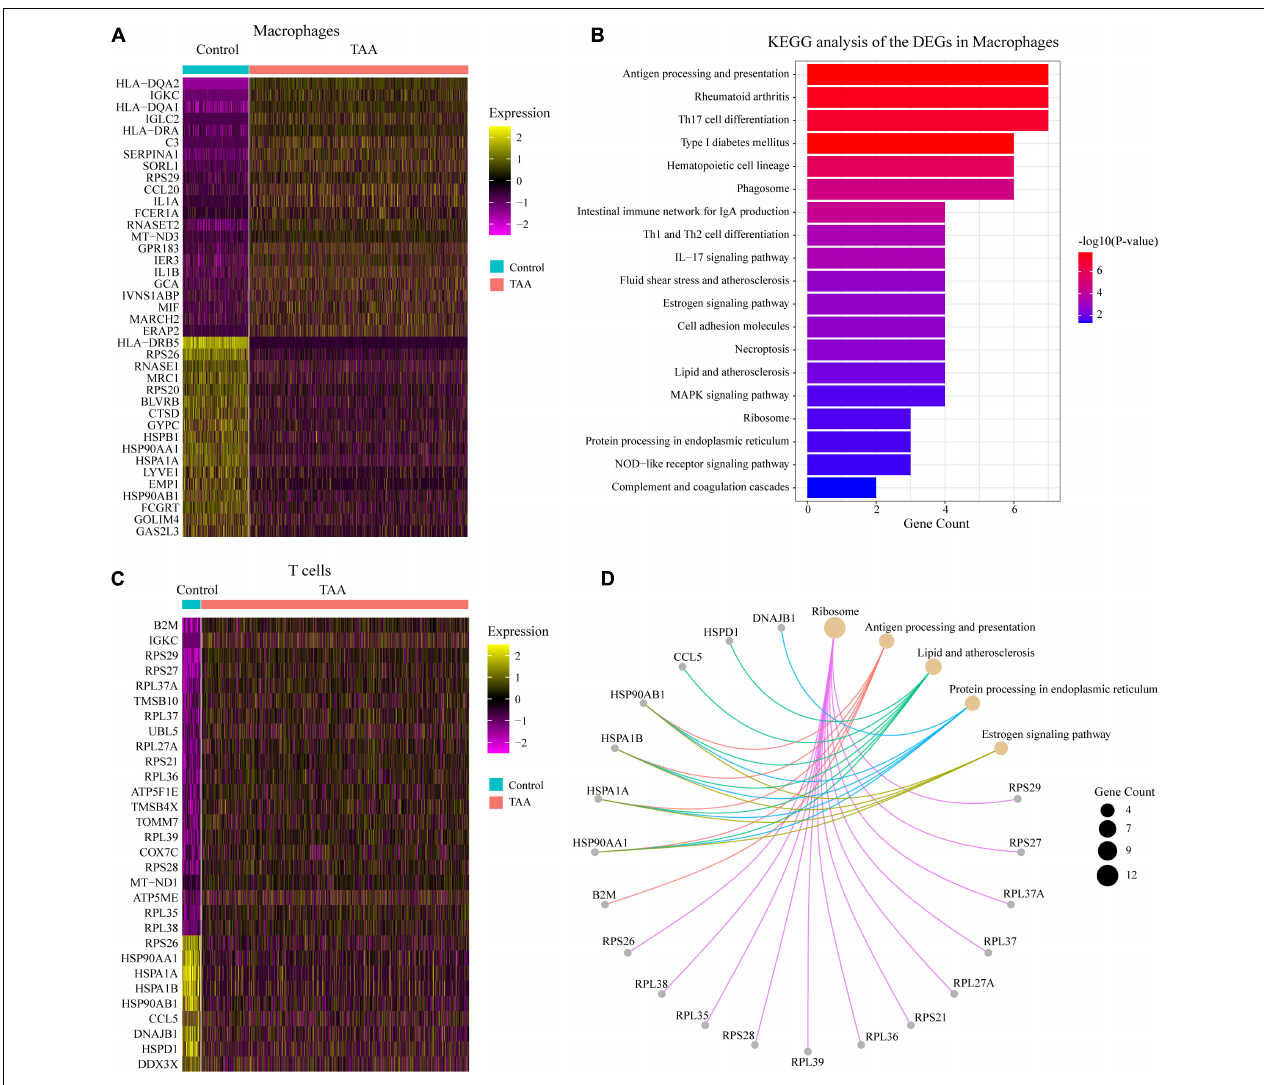
FIGURE 4 | Analysis of the macrophages and T cells. (A,C) Heatmaps show the expression of DEGs with log 2 (FC) > 0.25 and adjusted P -value < 0.05, selected from macrophages (A) and T cells (C) between TAA and control samples. (B,D) KEGG annotations of the DEGs in macrophages (B) and T cells (D) were performed. KEGG pathways with an adjusted P -value < 0.05 were considered